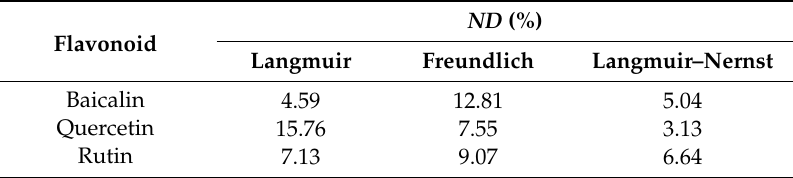
Table 2. Fitting degree of three equilibrium adsorption